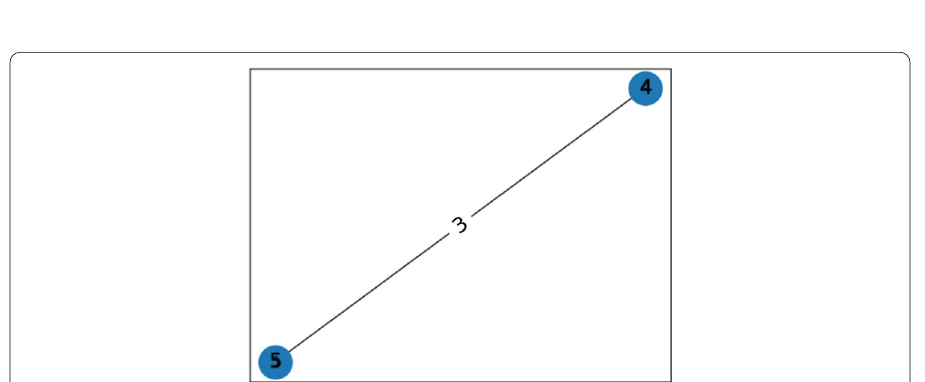
Fig. 3 Item association graph partition